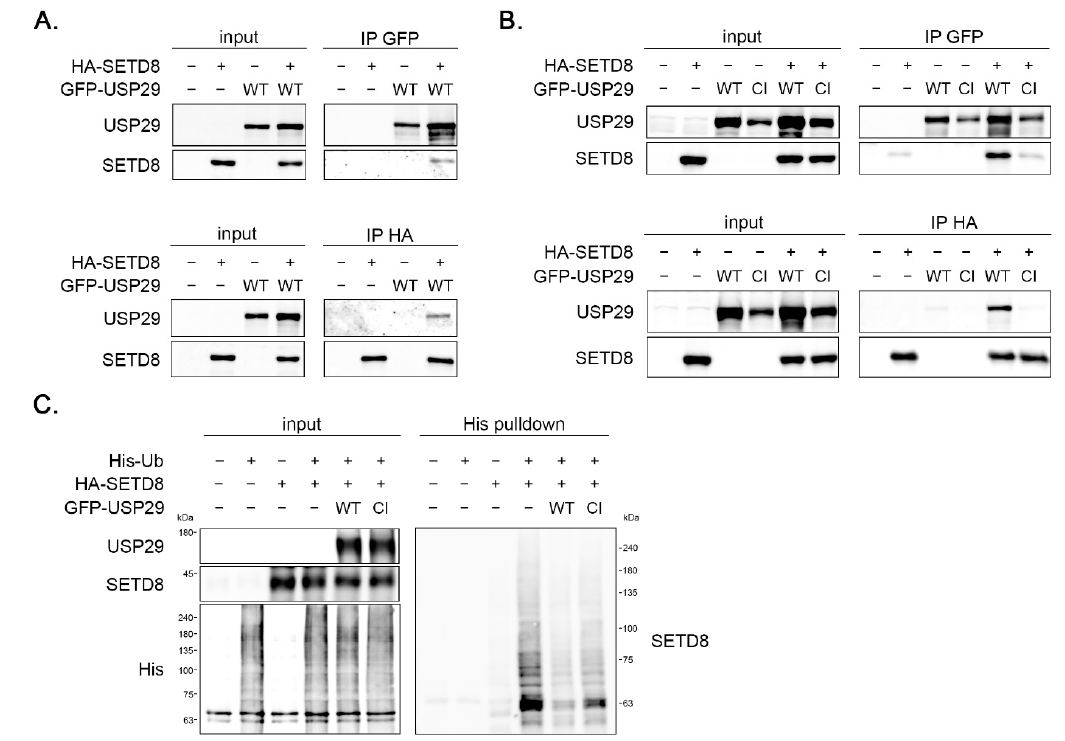
Figure 3. USP29 interacts with and deubiquitinates SETD8 in vivo. ( A ) The 293T cells were trans- fected with HA-SETD8 and/or GFP-USP29 wildtype (WT) expression vectors and lysed. GFP ( upper panel) or HA ( lower panel) immunoprecipitations were carried out and analyzed by Western blot with the indicated antibodies. ( B ) The 293T cells were transfected with HA-SETD8 and WT or catalytic inactive (CI) versions of GFP-USP29. GFP ( upper panel) or HA ( lower panel) immunoprecipi- tations were carried out and analyzed by Western blot with the indicated antibodies. ( C ) The 293T cells were transfected with HA-SETD8, His-Ub, and GFP-USP29 WT or CI. Cells were incubated with MG132 for 16 h before lysis. Then, a pulldown was performed with Ni-NTA beads followed by Western blot analysis using the indicated antibodies.